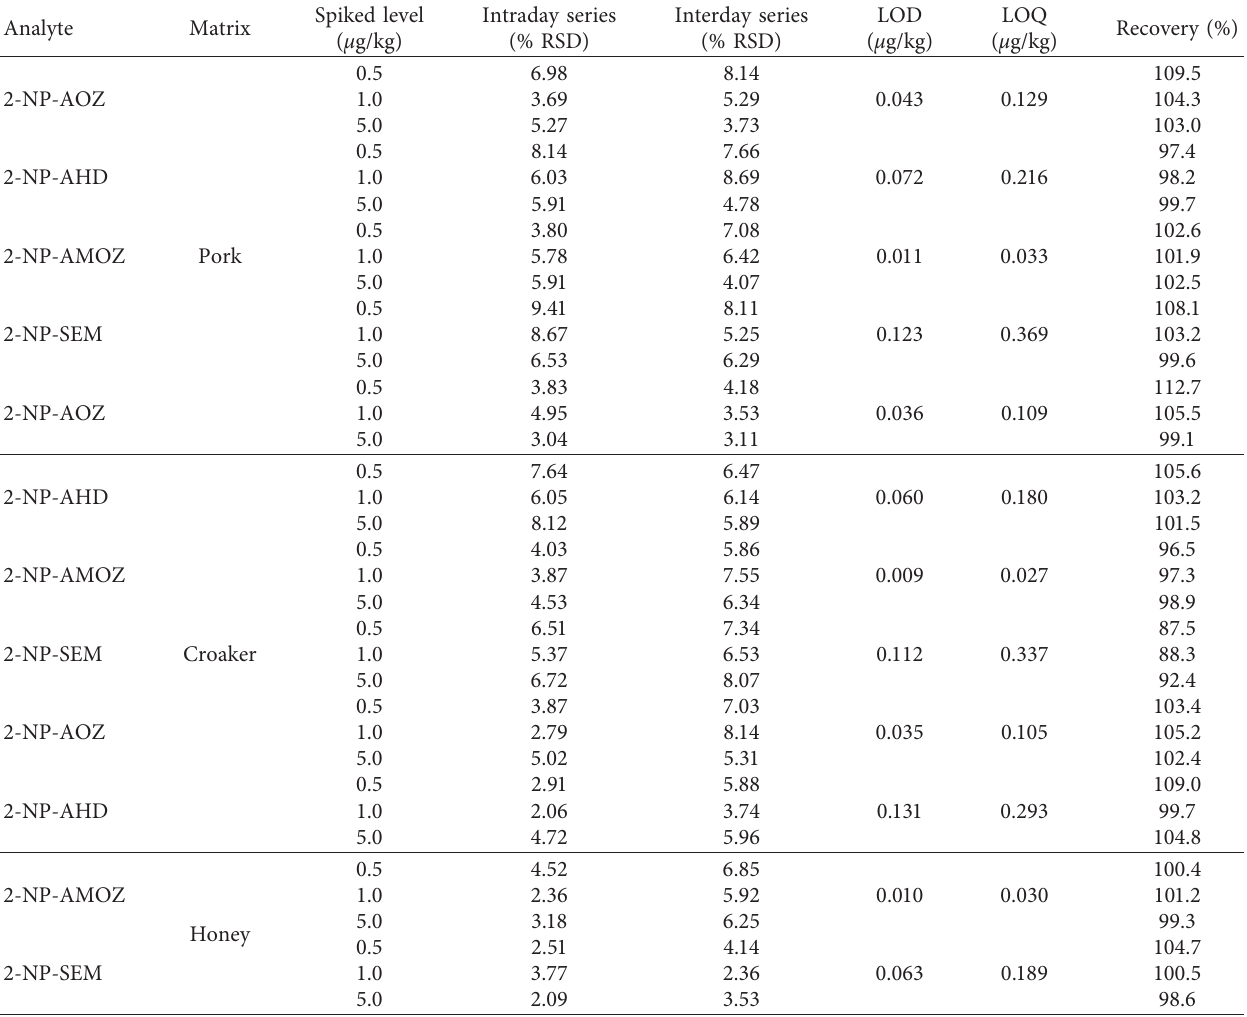
Table 3: Corrected intraday and interday accuracies and precision for complex matrix spiked with working standard solution ( n � 6).